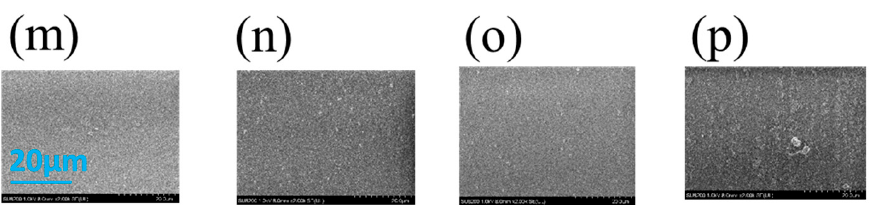
Figure 4. Photographs ( a – d ) and SEM images ( e – p ) on floor surface without HMs. ( a – d ) two black marks on the floor indicate the locations where the two electrodes were placed 10 mm apart, ( a , e , i , m ) Control floor surface, ( b , f , j , n ) The plasma-treated floor surface for 60 s. ( c , g , k , o ) The floor surface via plasma treatment for 180 s, and ( d , h , l , p ) The floor surface via plasma treatment for 300 s. ( e – h ) SEM images of ( a – d ) were taken at magnification of 100 for ( i – l ), 500 for ( a – d ), and 2000 for ( m – p ).